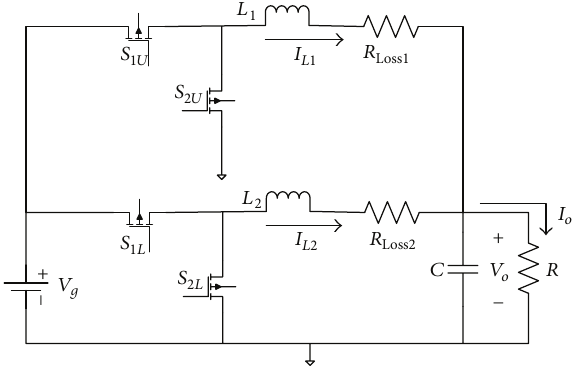
Figure 2: Buck converter in interleaved topology.